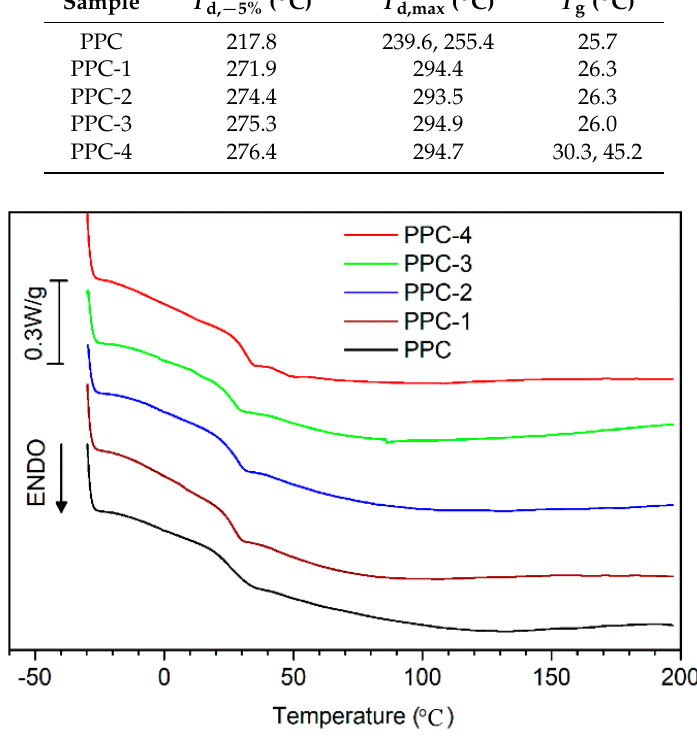
Figure 2. The differential scanning calorimetry (DSC) curves for PPC and PPC with networks. Table 2. The thermal properties of PPC and PPC with networks.